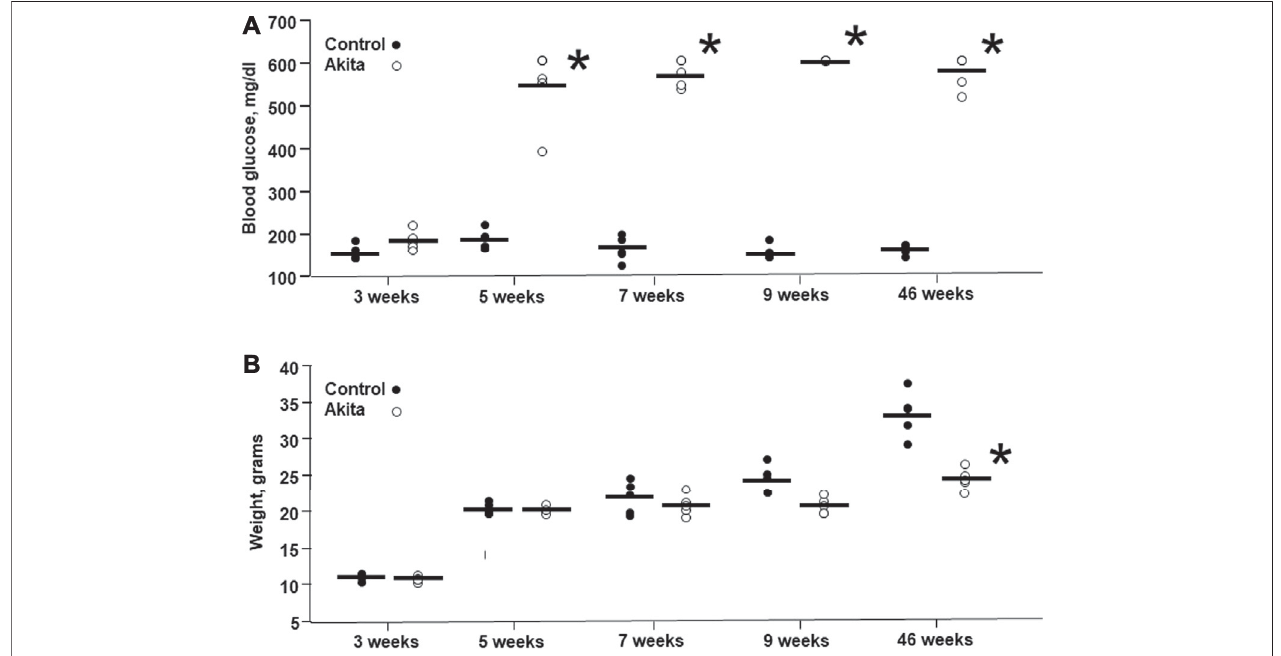
FIGURE 1 | Blood glucose levels and body weight in wild-type and Ins2 Akita mice animals at different ages. Blood glucose levels (A) are expressed in mg/dL, while body weight (B) is expressed in grams. The values are shown as fi lled dots for wild-type mice and open dots for Ins2 Akita animals * p < 0.05 student t-test, vs wild-type.